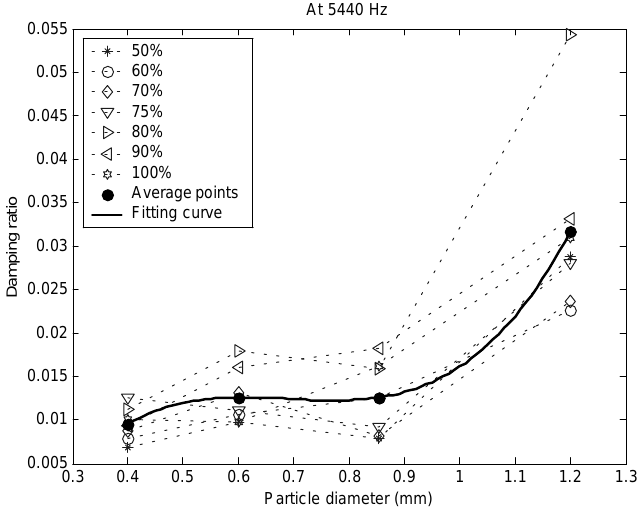
Fig. 14. Damping ratio vs. particle diameter for different packing ratios at 5440 Hz.